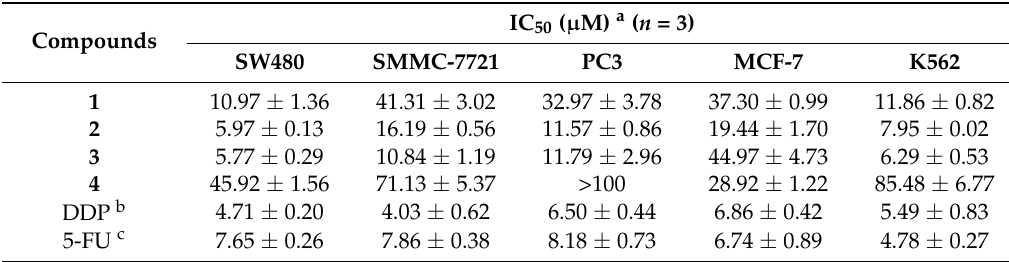
Table 2. Cytotoxicity of compounds 1 – 4 against SW480, SMMC-7721, PC3, MCF-7 and K562 cells in vitro.